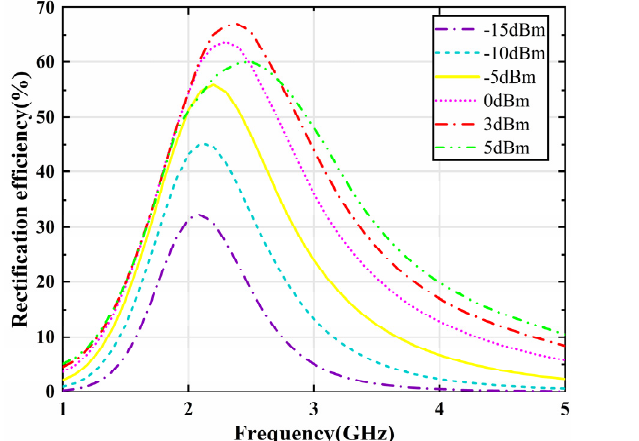
( b ) Figure 9. Simulated rectification efficiency of rectifiers versus input power at various loads. ( a ) 2.4 GHz. ( b ) 12.6 GHz.